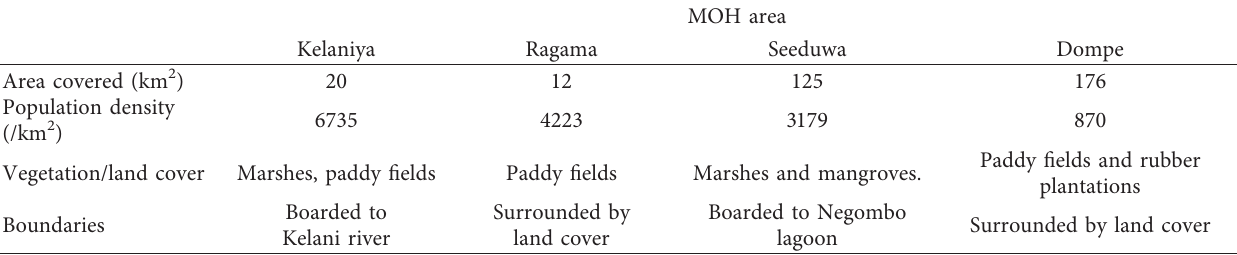
Table 1: Descriptive information of four MOH